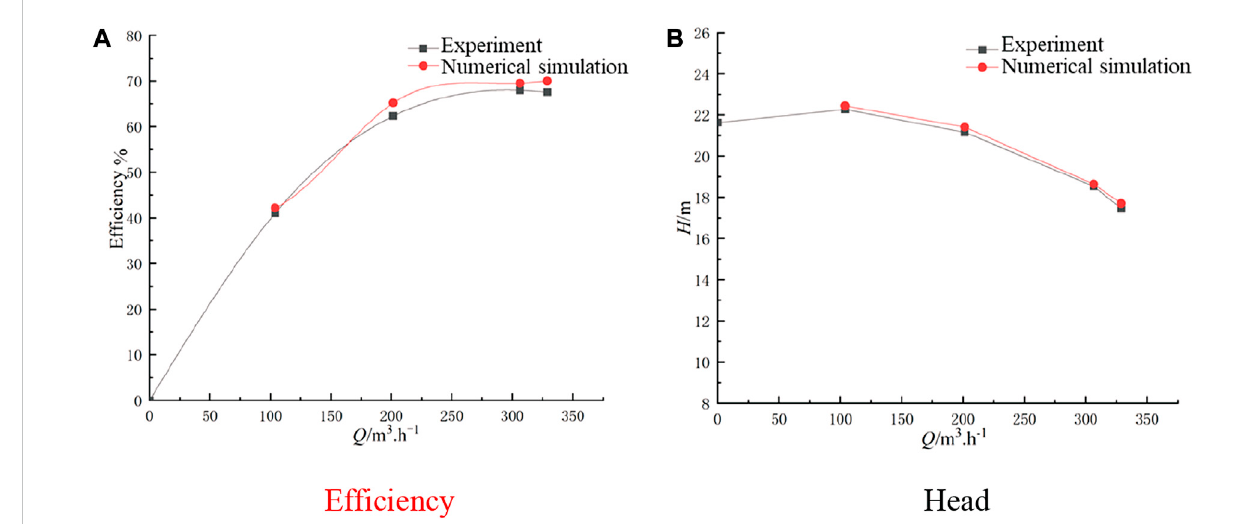
FIGURE 3 Comparison of hydraulic characteristics between numerical simulation and experiment. (A) Ef fi ciency; (B) Head.